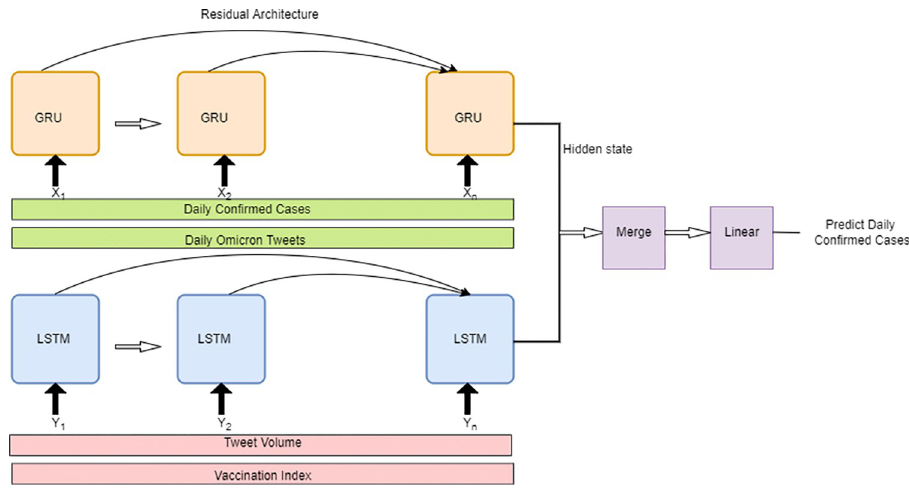
Fig 1. Framework